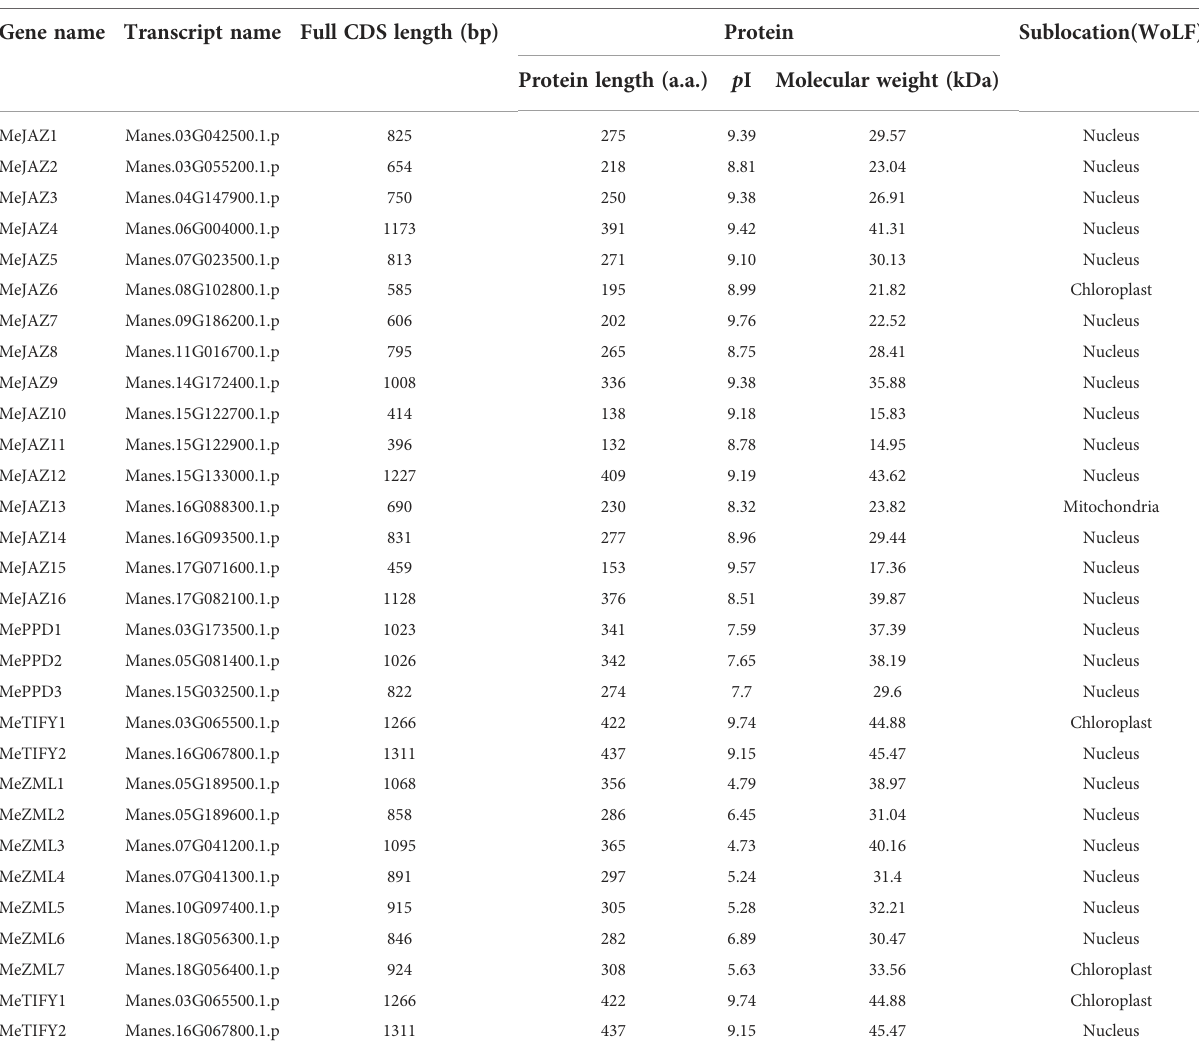
TABLE 1 Details of the TIFY family in